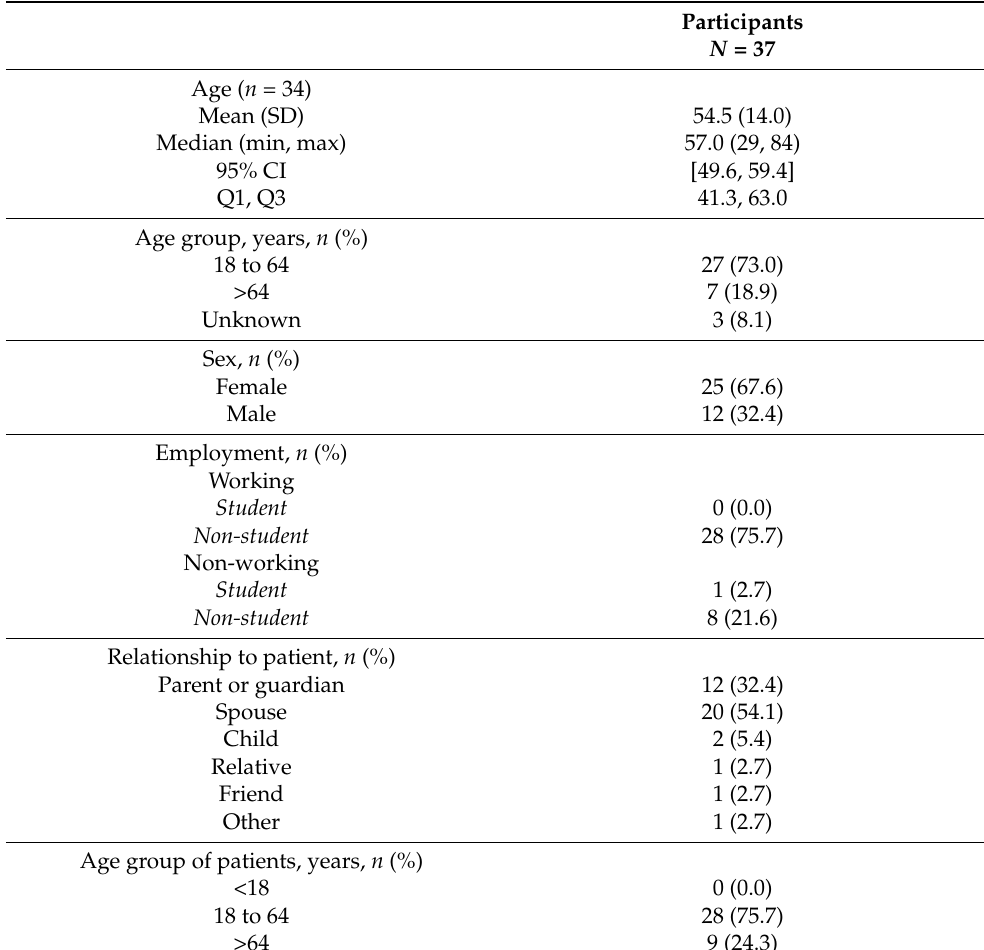
Table 1. Demographics of survey